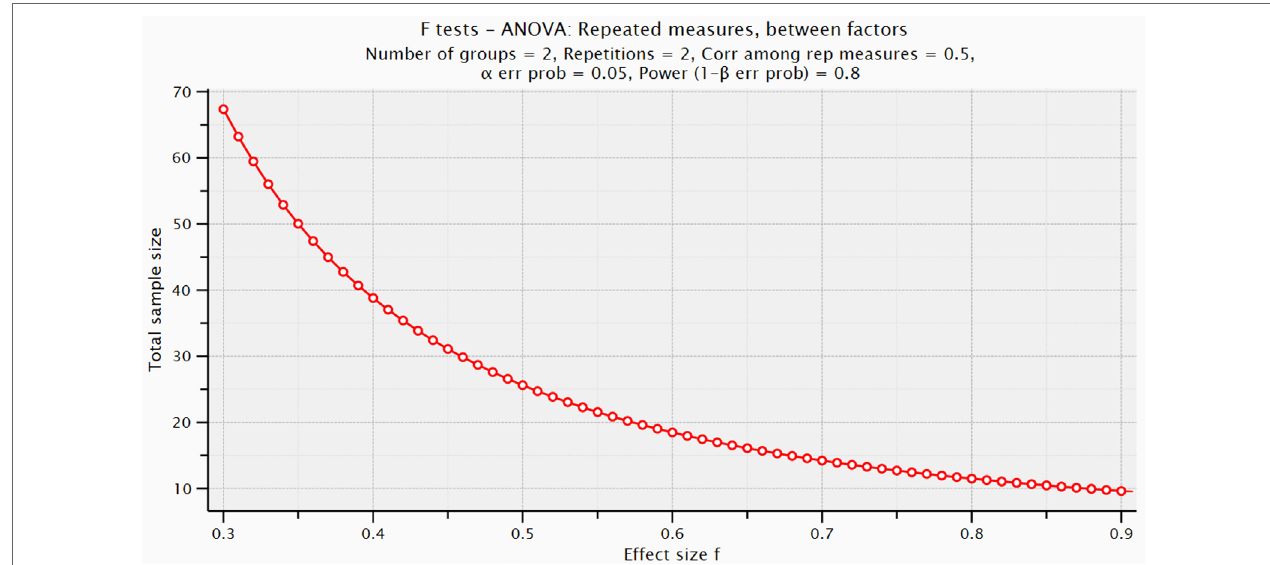
FigurE 2 | Effect size as a function of total sample size for power of